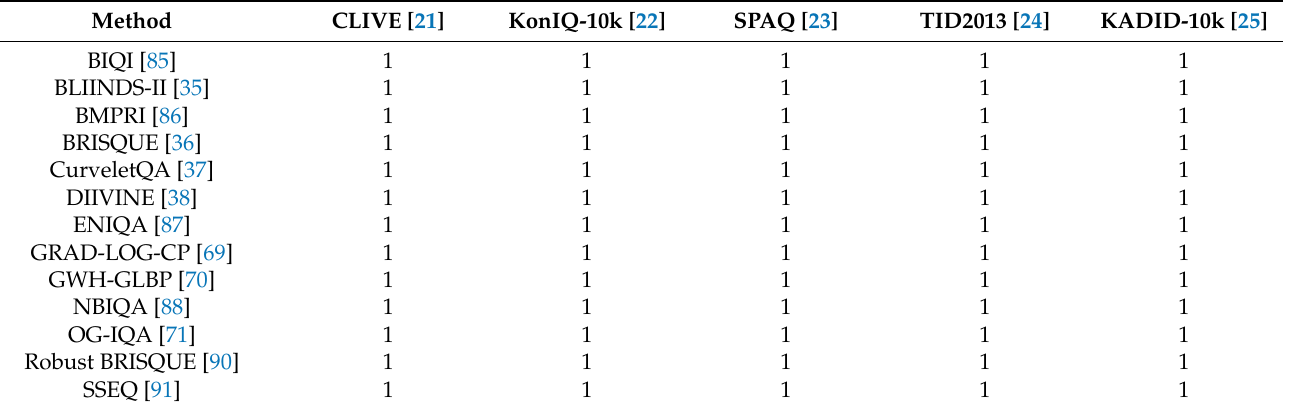
Table 7. Results of the two-sided Wilcoxon rank sum test. Symbol ‘1’ is used to denote that the proposed method—LFD-IQA-GPR—is significantly better than the method in the row on the database in the